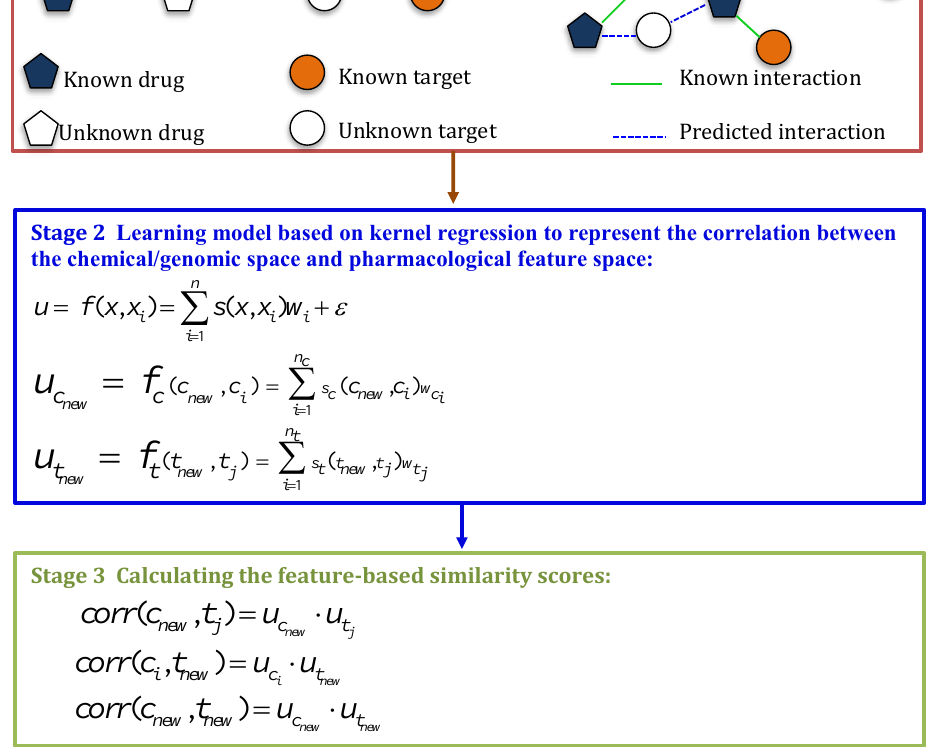
Figure 5. The flowchart of Kernel Regression Method